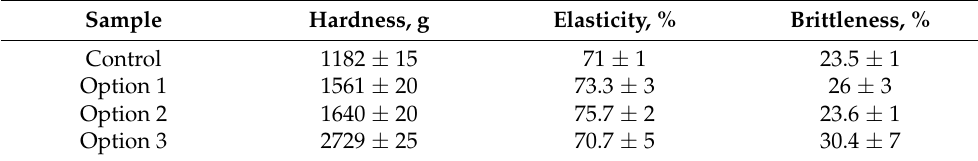
Table 4. Correlation dependencies for sponge cake layers related to textural